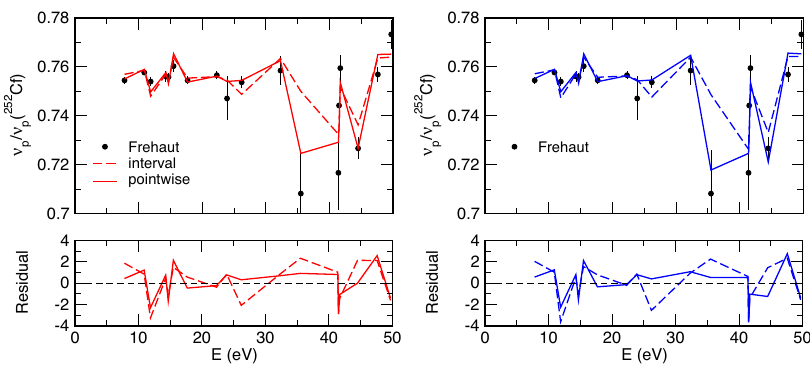
Figure 3. Comparison between the results obtained fitting the averaged and pointwise data from Fréhaut, using the Γ γ f from the works of Trochon et al. (left panel), and Lynn et al. (right panel).